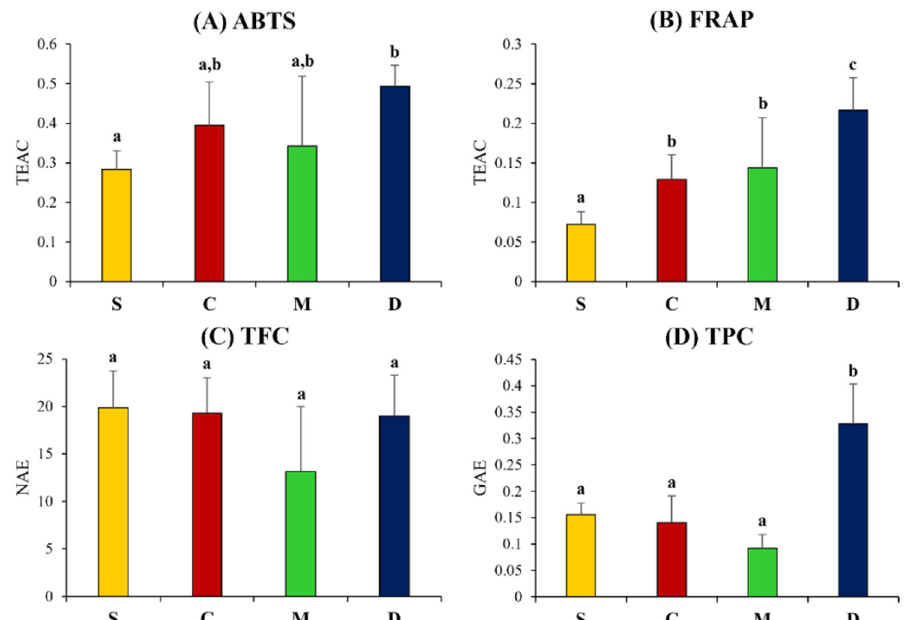
Figure 4. Total flavonoid, phenolic contents, and antioxidant activity tests. ( A ) 2,2-azino-bis-(3- ethylbenzothiazoline-6-sulfonic acid) diammonium salt (ABTS) and ( B ) ferric reducing antioxidant power (FRAP), as well as ( C ) total flavonoid contents (TFC) and ( D ) total phenolic contents (TFC). S, soy; C, cheonggukjang; M, meju; D, doenjang. Values are expressed as the average of three bio- logical replicates (n = 3). Bar graphs denoted by the same letter were not significantly different, according to Duncan’s multiple range test ( p -value < 0.05).